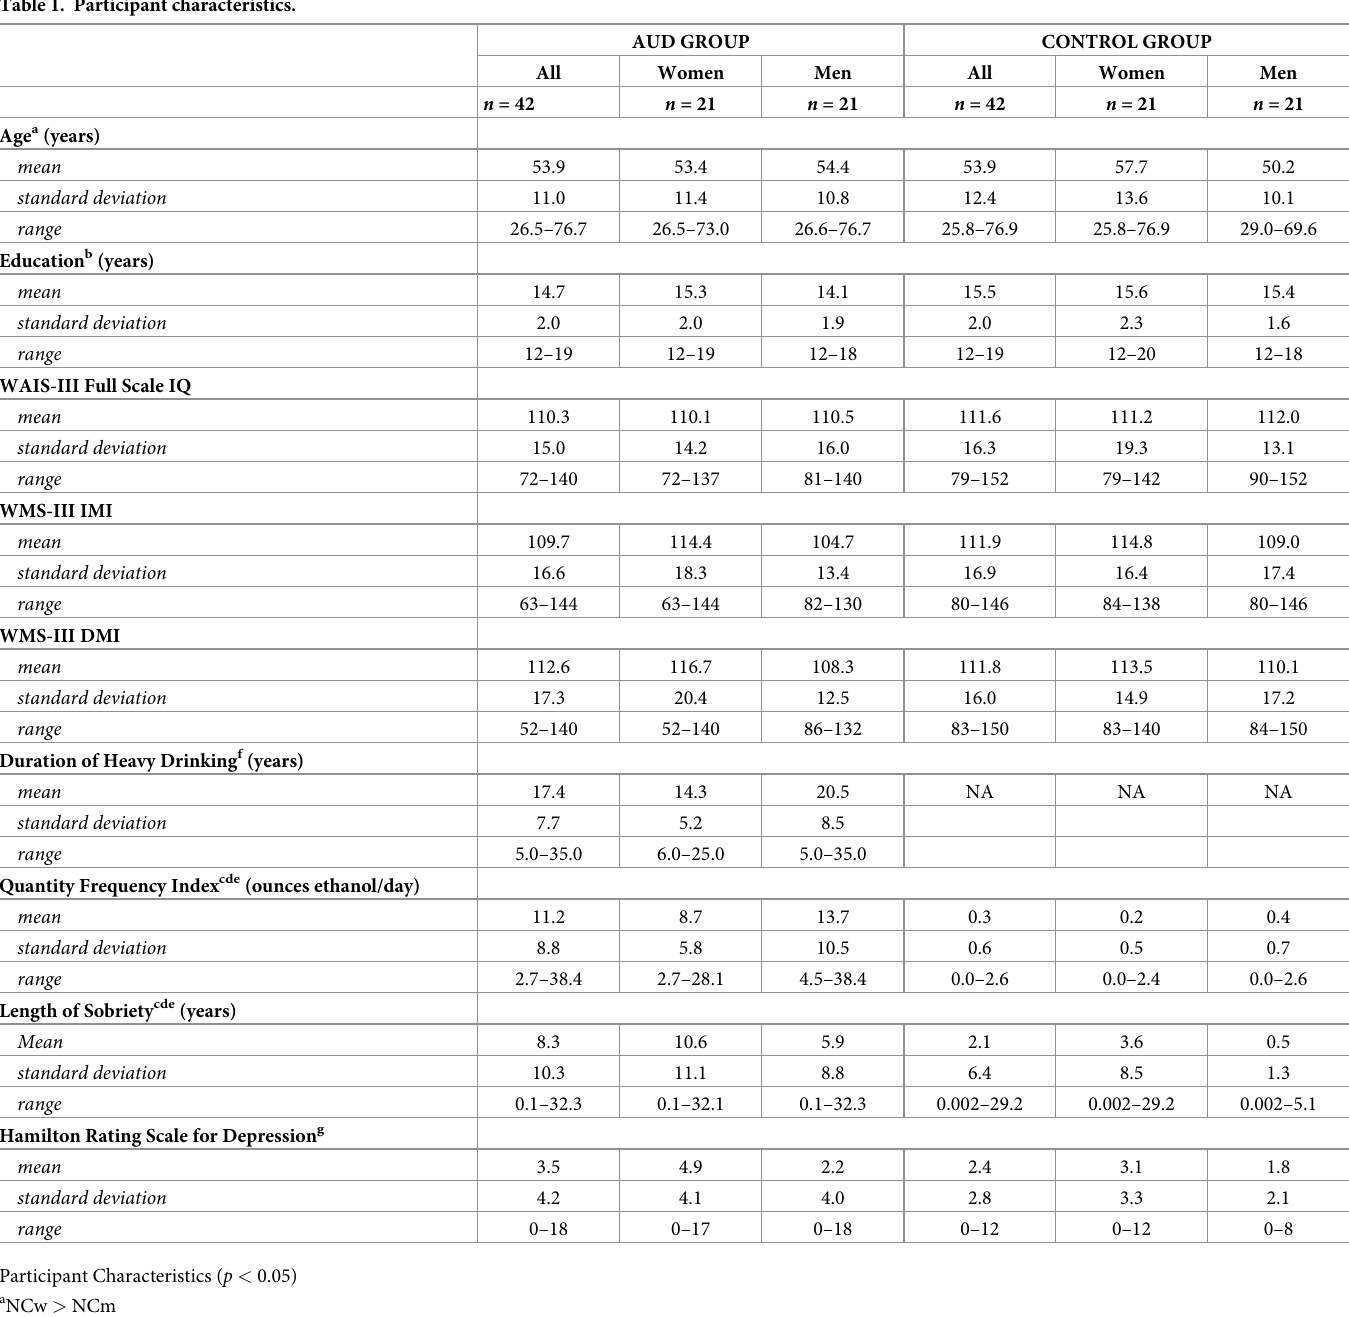
Table 1. Participant